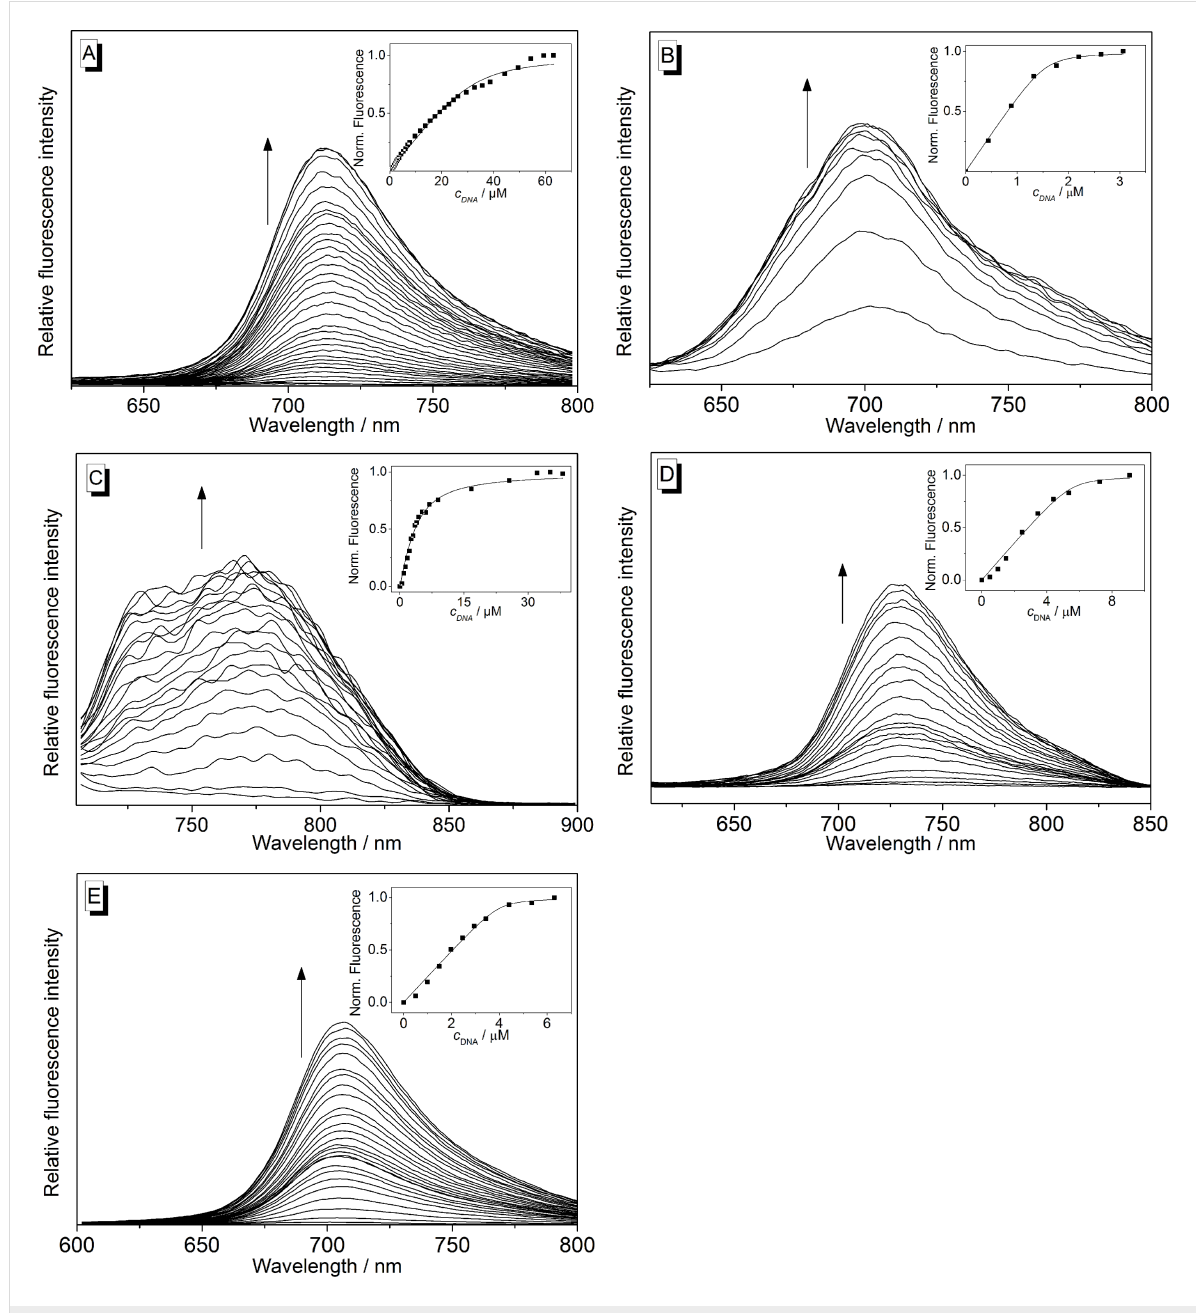
Figure 5: Fluorimetric titration of 1a (A), 1b (B), 1c (C), 1d (D) and 1e (E) with a2 in potassium phosphate buffer (95 mM, pH 7.0); A, B, E: c Lig = 5.0 μ M; C, D: c Lig = 10 μ M; A: λ ex = 385 nm; B: λ ex = 364 nm; C: λ ex = 431 nm; D, E: λ ex = 580 nm. Arrows indicate the development of the bands with increasing DNA concentration. Inset: Plot of the normalized emission intensity versus DNA concentration. Lines denote the best fit of experimental data to the theoretical